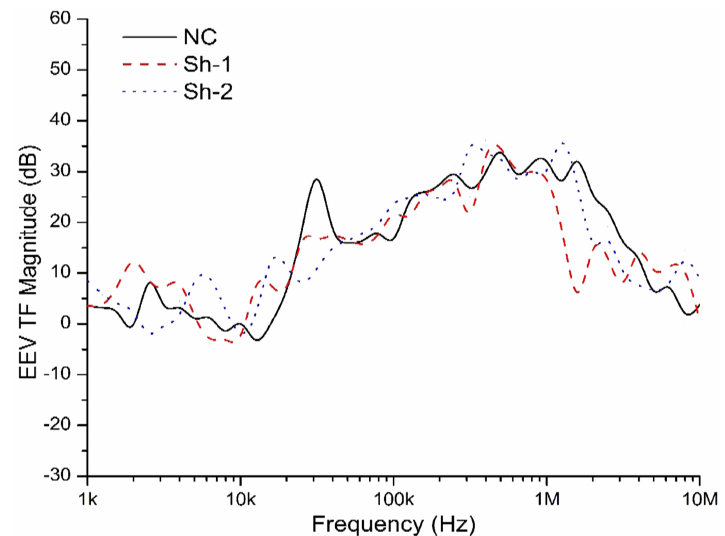
Figure 6. Comparison of End to End Voltage Transfer Function (EEV TF) plots for the inter-turn short diagnosis: Normal case (vs) Sh-1 (vs) Sh-2.